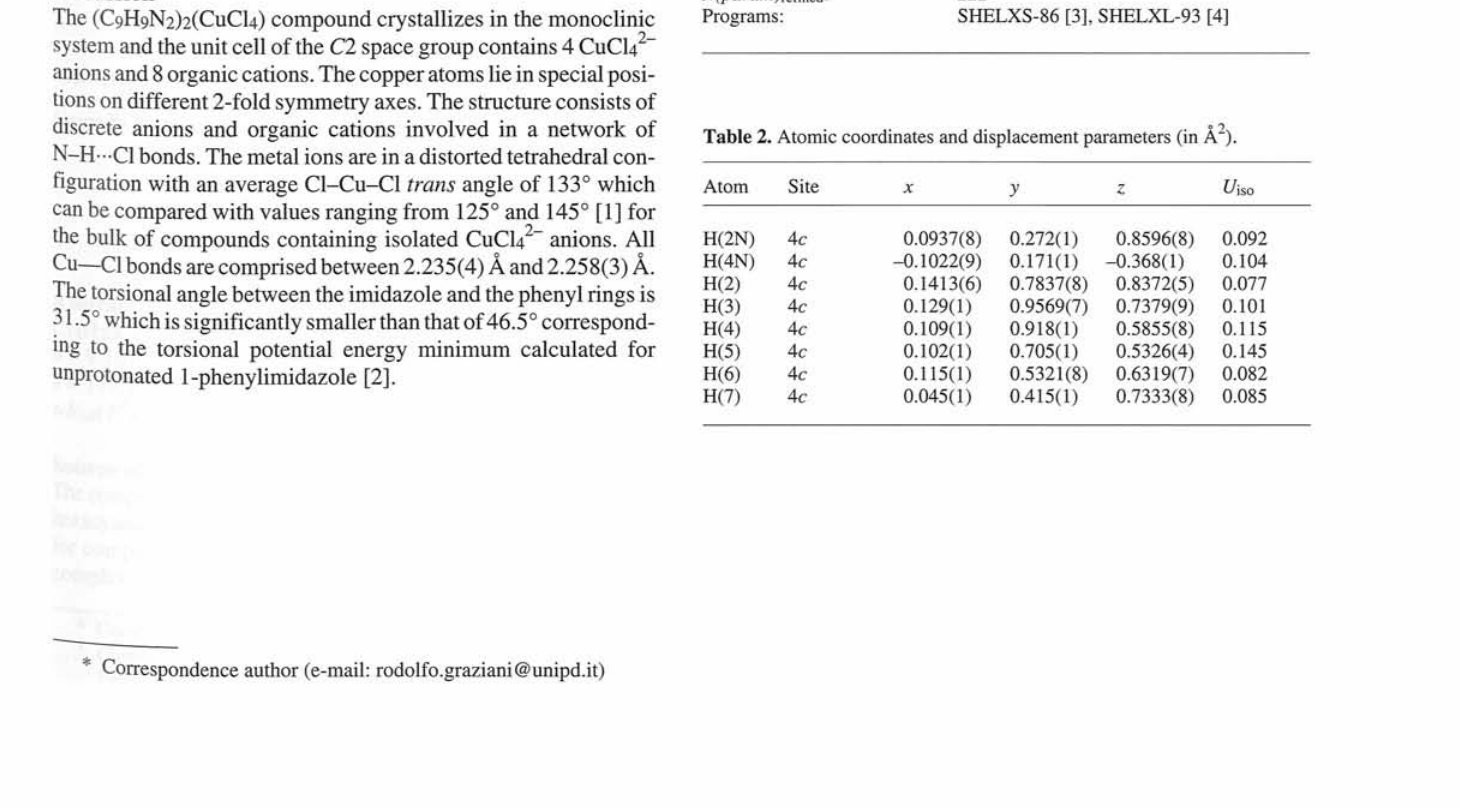
Table 2. Atomic coordinates and displacement parameters (in